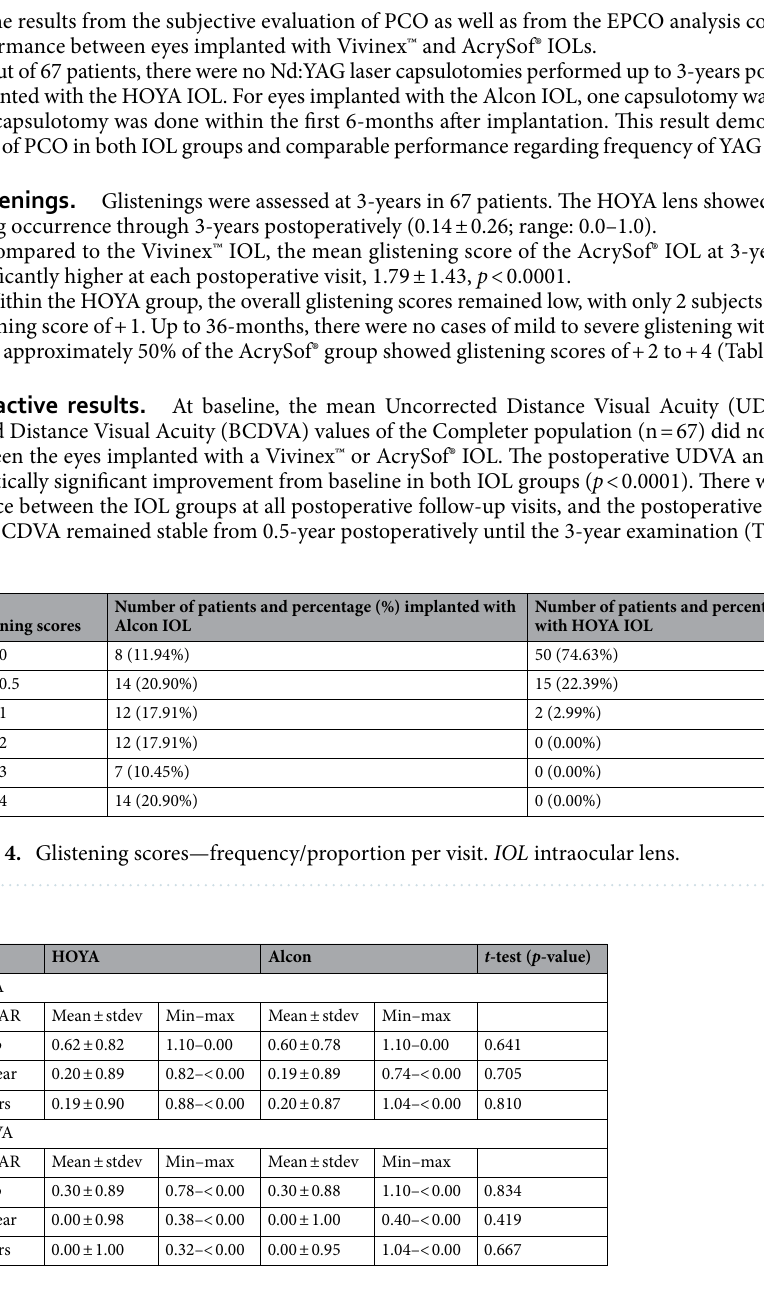
Table 5. UDVA and BCDVA values of the completer population (n = 67). UDVA uncorrected distance visual acuity, BCDVA best-corrected distance visual acuity, logMAR logarithm of the minimum angle of resolution, stdev standard deviation.